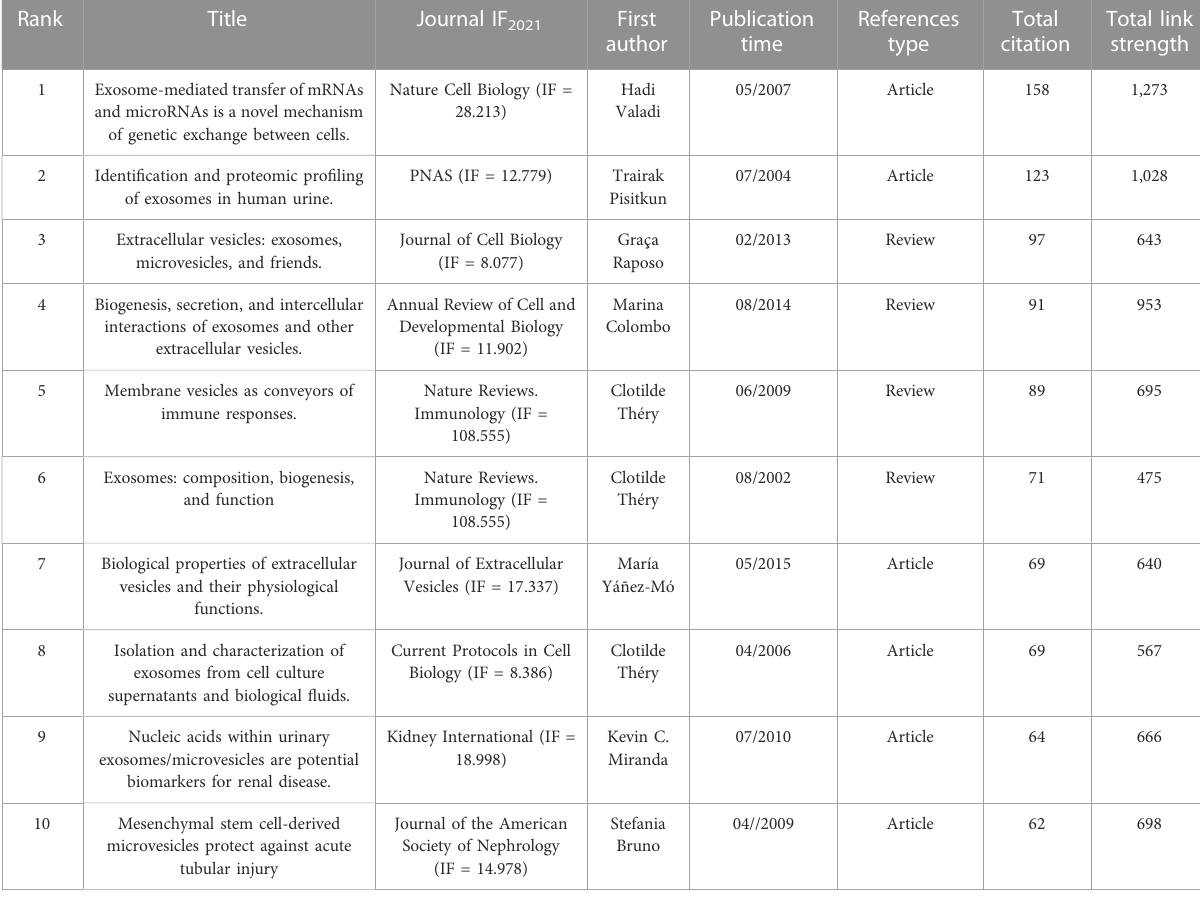
TABLE 4 Top 10 co-cited references related to EVs in kidney